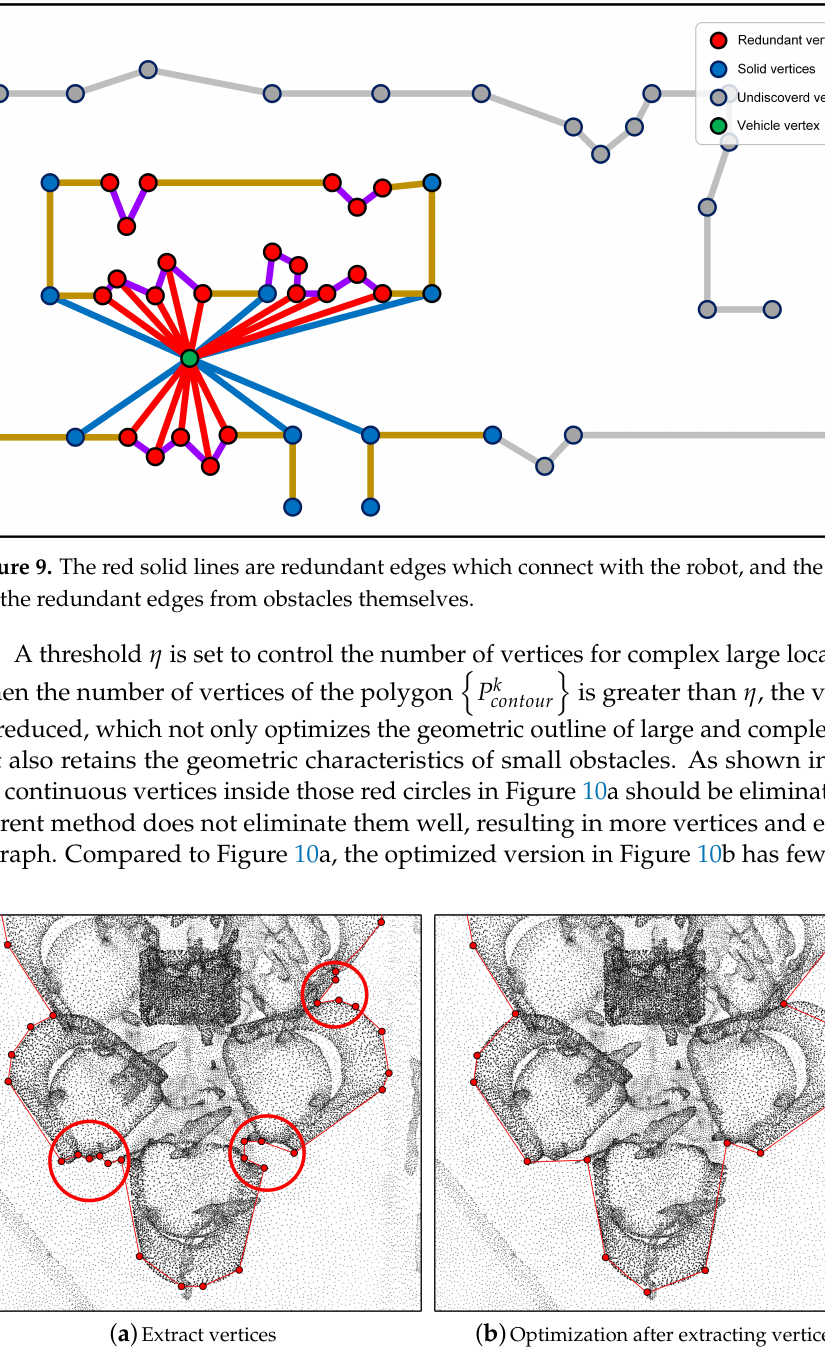
Figure 10. ( a ) shows the obstacle vertices extracted after pointcloud mapping. ( b ) shows the remaining obstacle vertices after optimizing the ( a